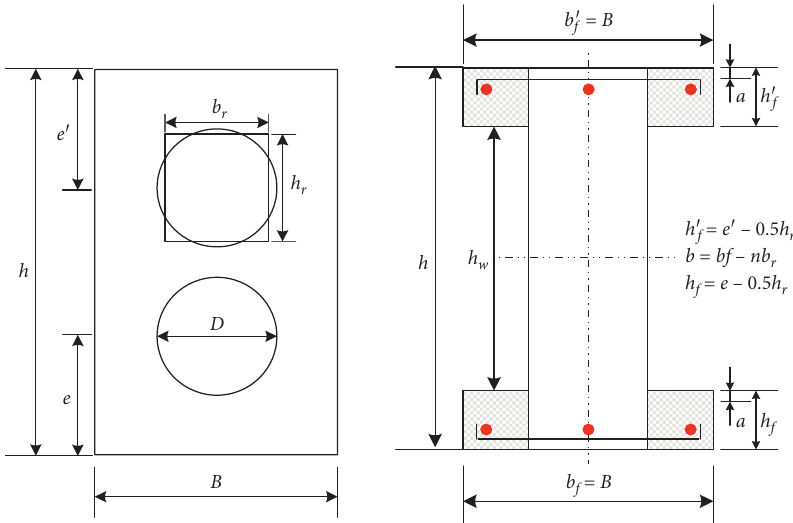
Figure 16: Equivalent I-shaped cross section of the concrete cable